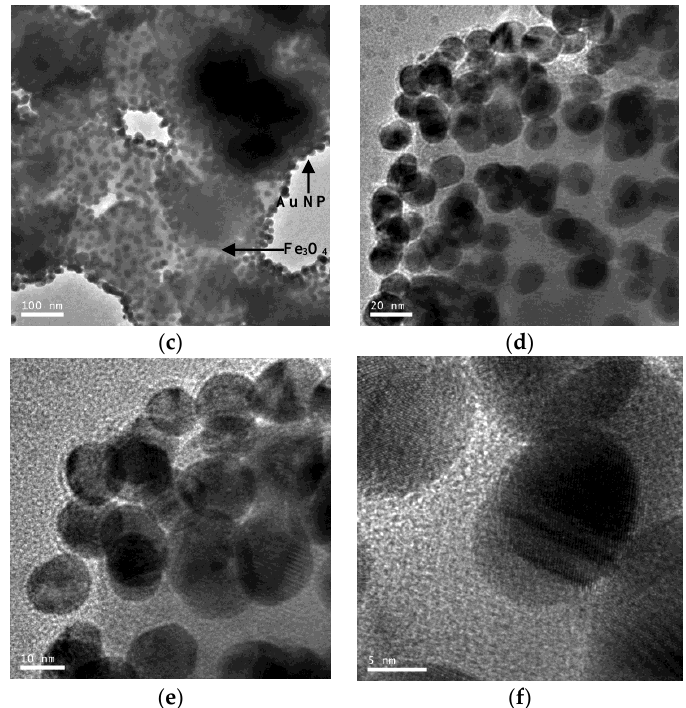
Figure 2. Transmission electron microscope (TEM) images of Fe 3 O 4 nanoparticles ( a ), Au nanoparticles ( b ), Fe 3 O 4 /Au nanoparticles at normal resolution ( c – e ), and high resolution ( f ).